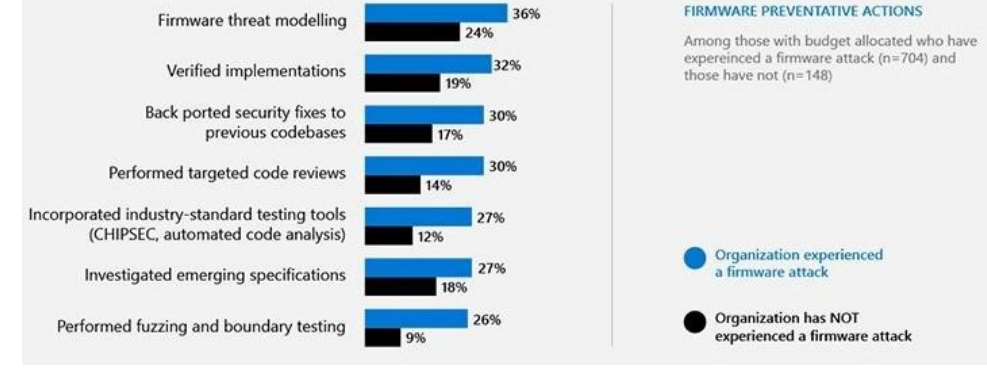
Figure 1. Organization Experienced a Firmware Attack, the figure was cited from Microsoft